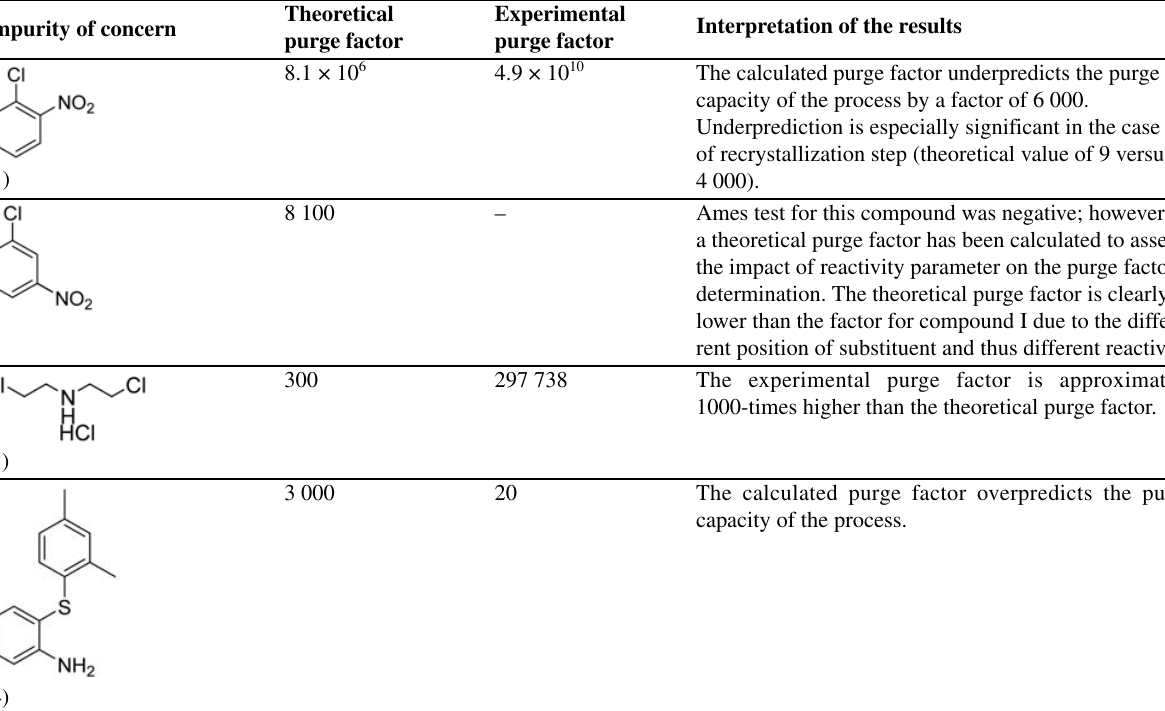
Table 7. Summarized results of the case study for the synthesis of vortioxetine (based on Lapanja et al. 29 ). Impurity of